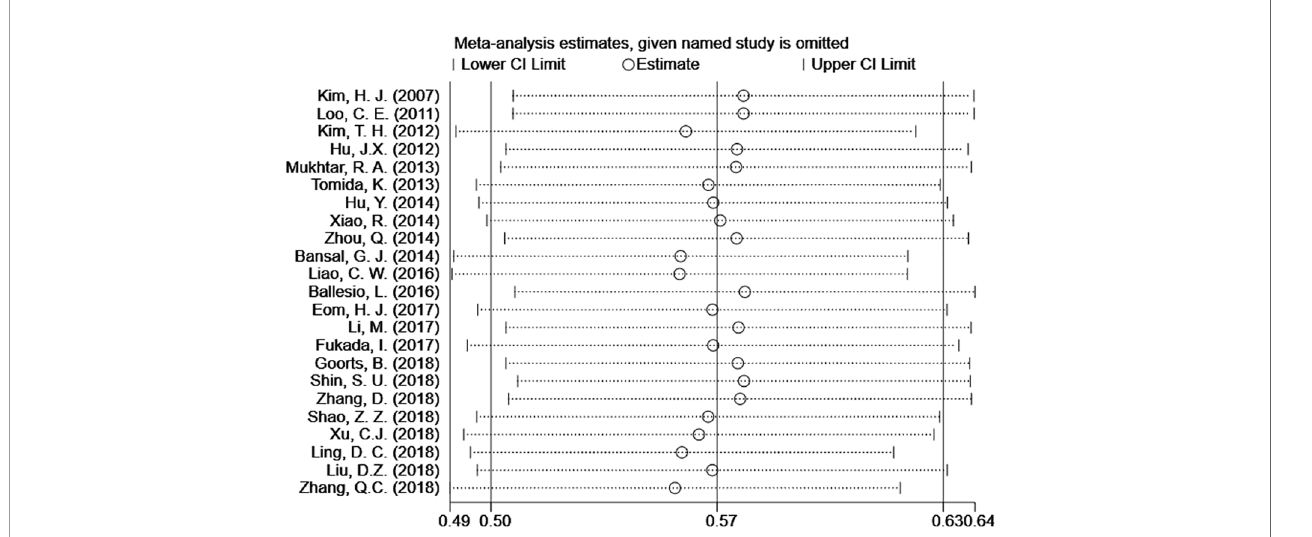
FIGURE 4 | Meta-analysis estimates, given named study is omitted. The results shows that only little variation in the estimates of CSM% is induced by omission of the one selected study. CI, con fi dence